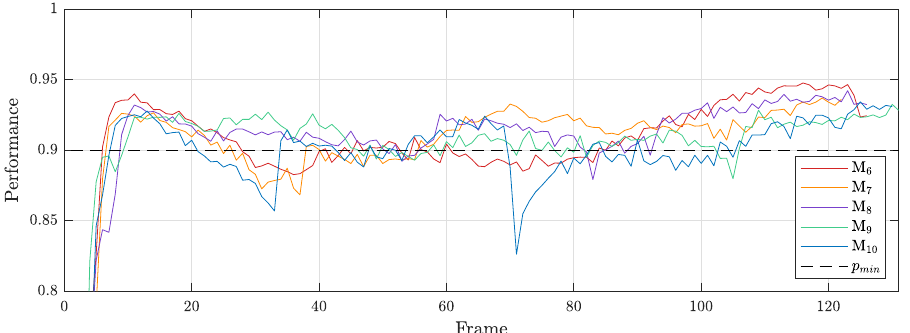
Figure 18. Performance p E of the elastography algorithm of I 4